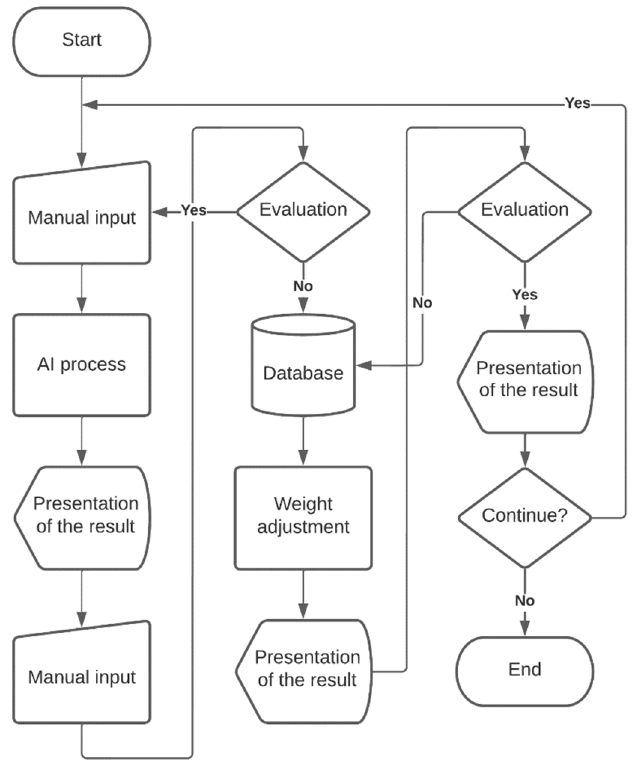
Figure 2. Flowchart for the design of a recognition system for teaching the number N to preschool children.